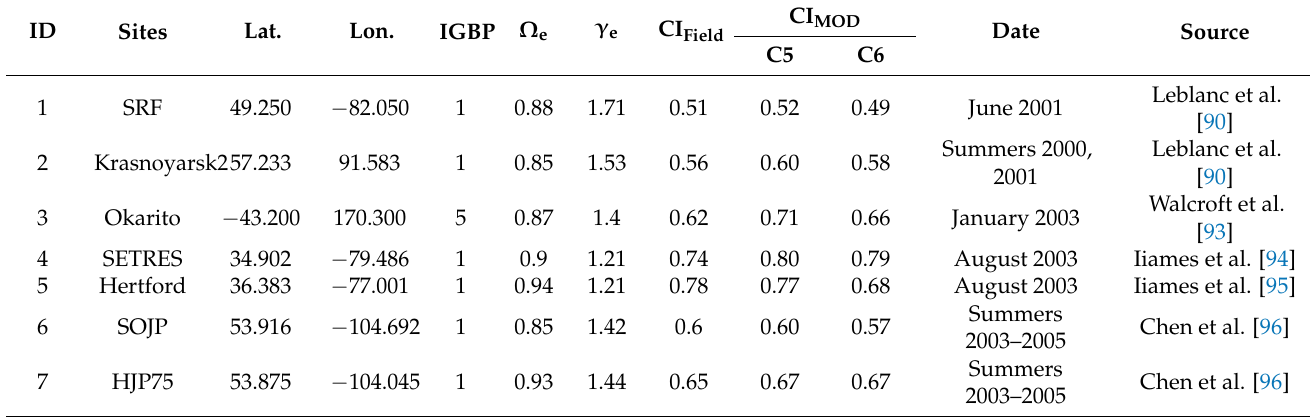
Table 1. Characteristics of 48 validation sites and corresponding MODIS CIs. IGBP is the classification code of the International Geosphere-Biosphere Programme (IGBP) classification scheme. Ω e denotes the clumping of foliage elements, and γ e is the needle-to-shoot area ratio. CI Field and CI MOD refer to field-measured CIs and MODIS-derived monthly CIs,